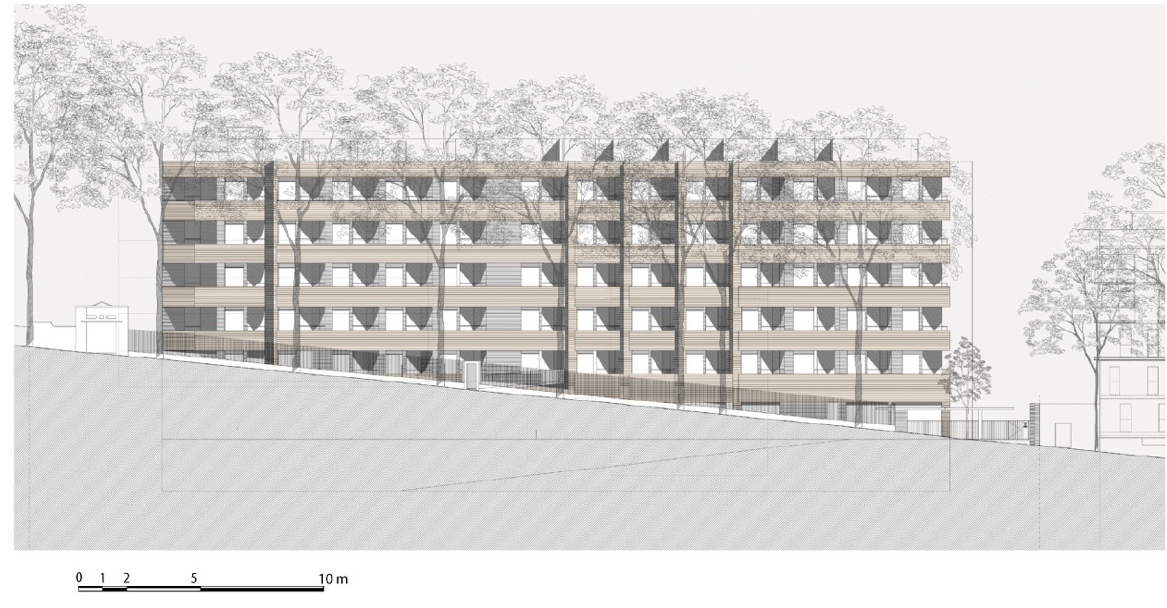
Figure 24. Porto. Main facade.